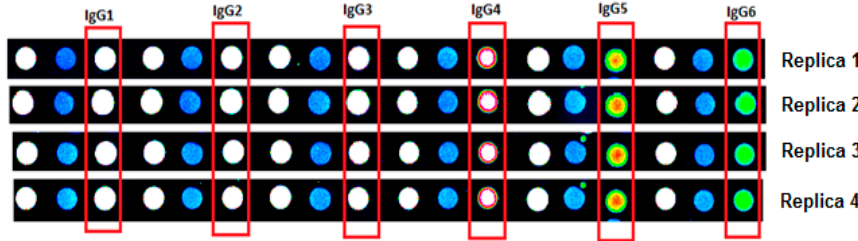
Figure 1. Sengenics-Immunome ™ Protein Array quadruplicate images for IgG control spots showing serial dilution (Left to right).